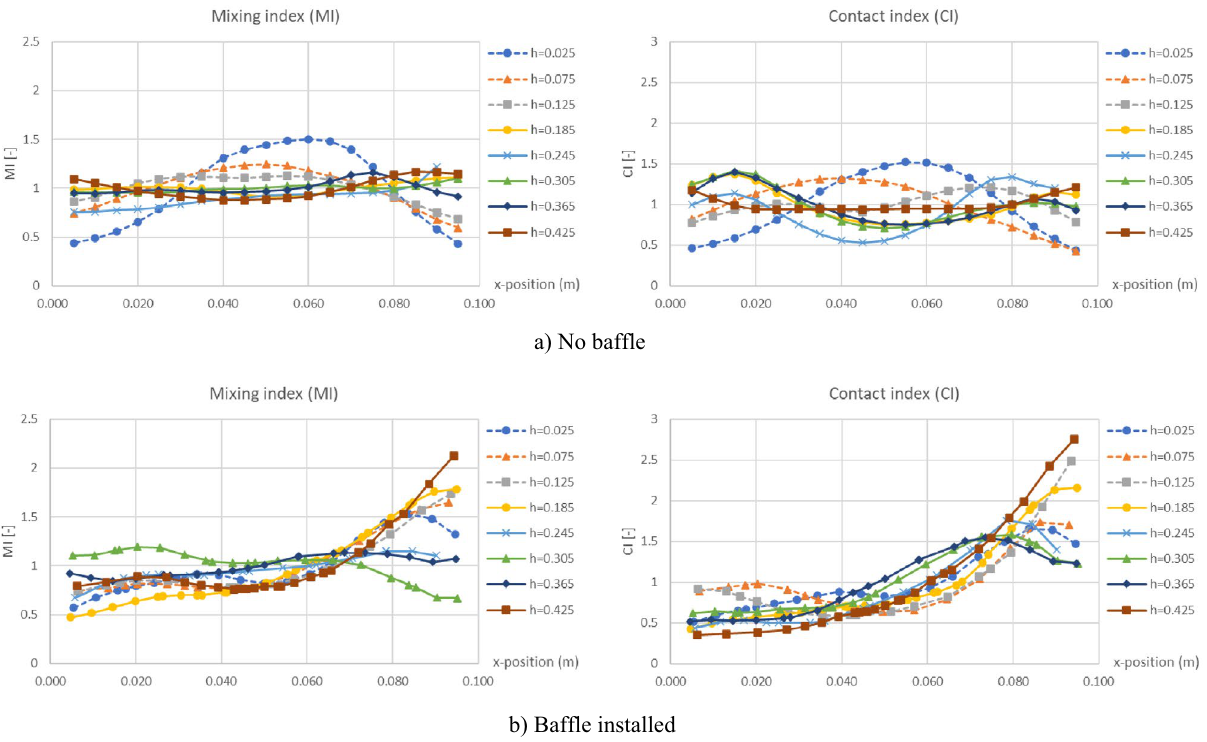
Figure 18. Time-averaged horizontal mixing index (left) and contact index (right) at different heights in case of biomass feeding at middle and U g = 0.7